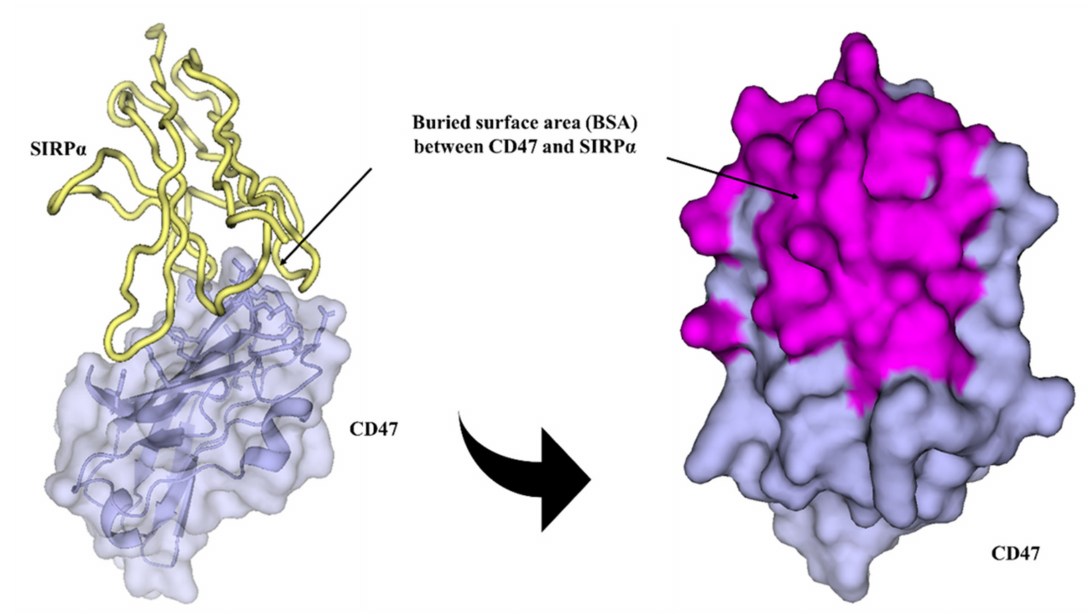
Figure 9. Buried surface area (BSA) between chain A (SIRP α , 2JJS) and chain C (CD47, 2JJS). Chain A and chain C are shown in yellow and light blue, respectively. The CD47 is shown as surface, and the interfacing residues are highlighted in magenta. Table 1: Comparing IMM01/CD47 structure with the structure in the literature (PDB ID 2JJT), the interactions are the same, and all the hydrogen bonds that appear in the structure in the literature are also present in this structure. These common hydrogen bonds are chain A:C and chain B:D. These hydrogen bonds are stable under different crystal packing styles, suggesting that these hydrogen bonds are important for protein binding.